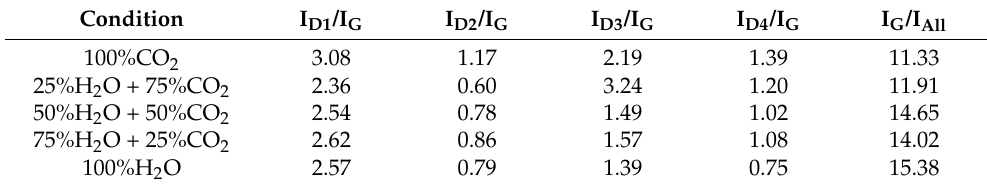
Table 4. Calculation results of peak area obtained by fitting from Figure